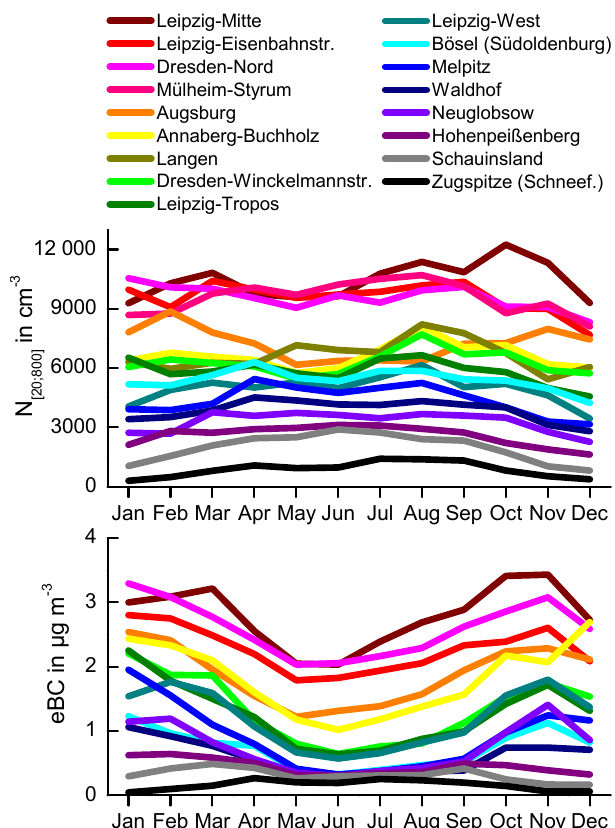
Figure 4. Preview of the mean annual cycles of total particle num- ber concentration ( N [ 20 ; 800 ] ) and eBC mass concentration. The data coverage ranges between 2 and 6 years (see text and Table